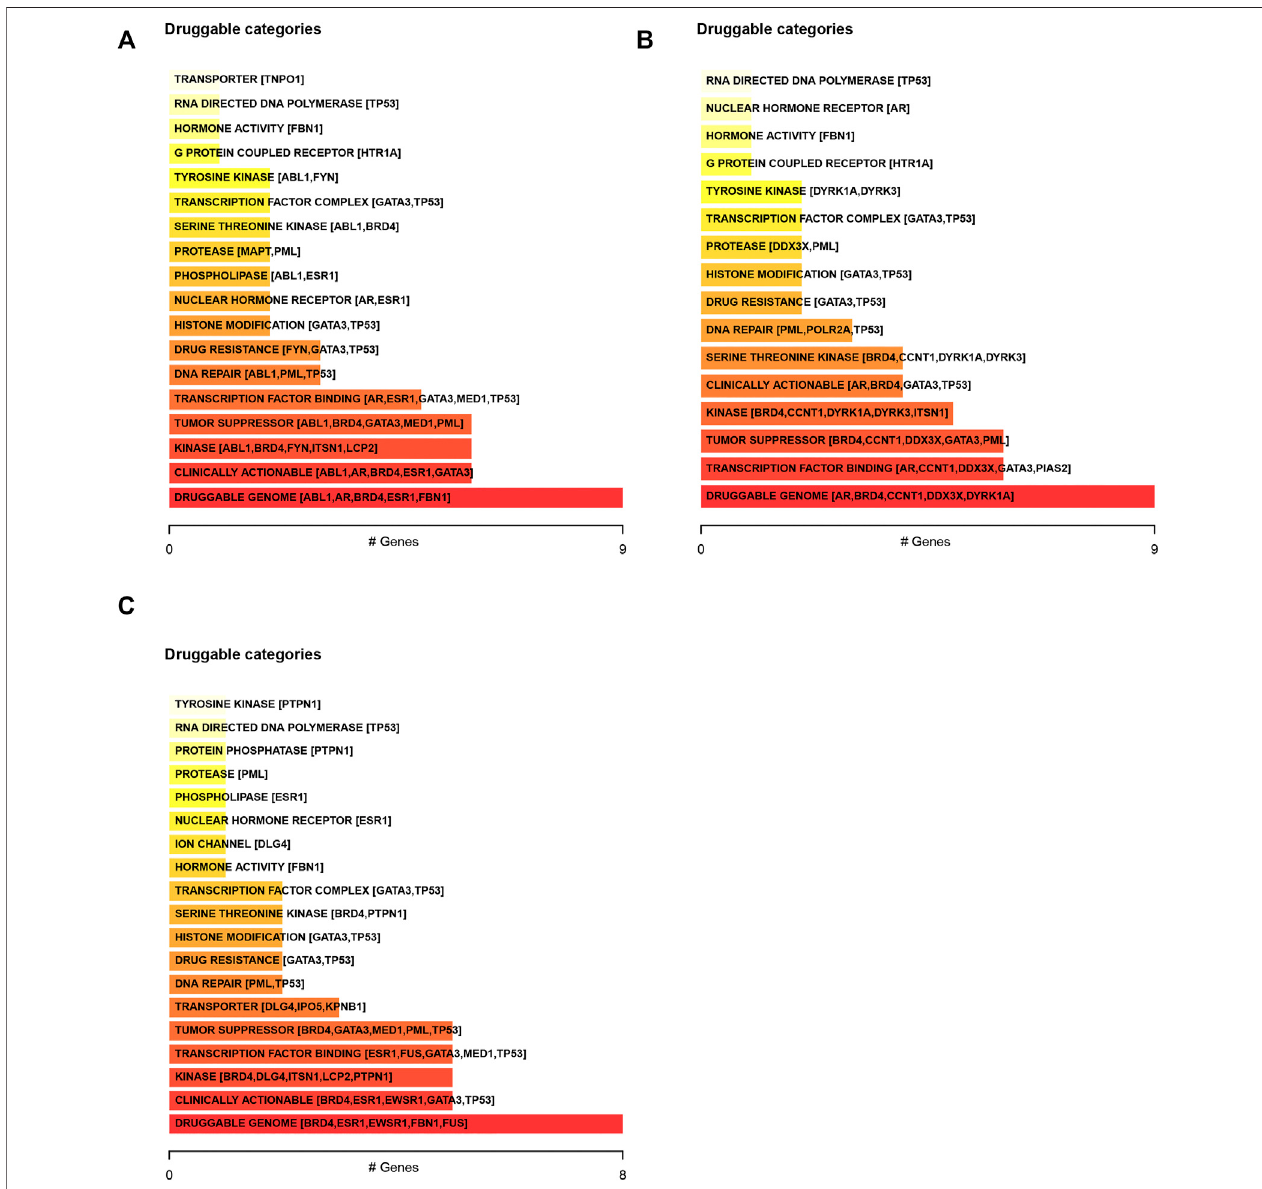
FIGURE4| PredictingthedrugresponseindigestivesystemneoplasmsbasedongeneticalterationsofLLPSregulators. (A – C) Wepredictedthedrugresponsein COAD (A) , STAD (B) , and ESCA (C) patients based on genetic alterations of LLPS regulators.